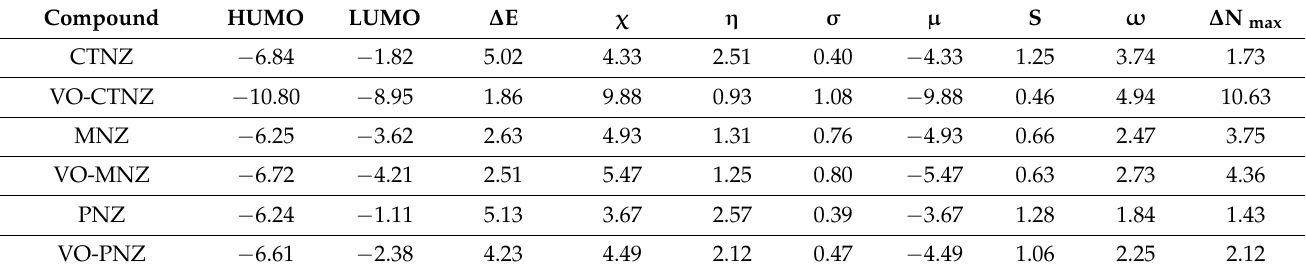
Table 4. Thecalculatedquantumchemicalparametersoftheligandsandtheiroxidovanadium(IV)complexes.